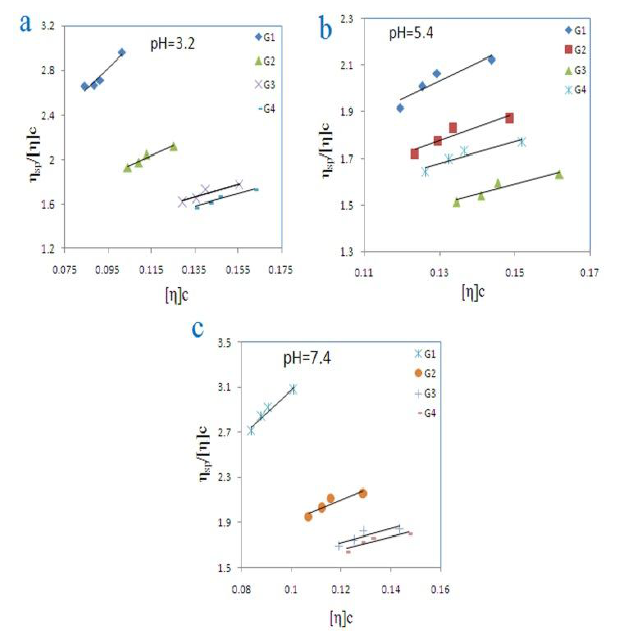
Fig. 5. Huggins function vs. reduced concentration for gelatin nanoparticles at different pHs, pH= 3.2 (a), pH =5.4 (b) and pH =7.4